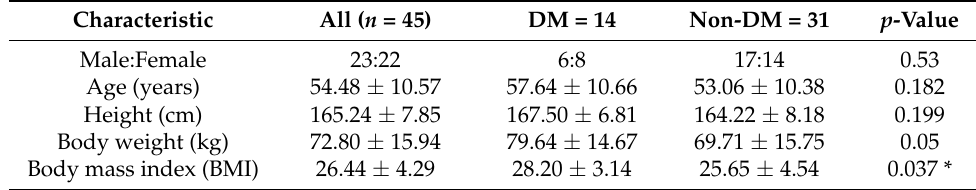
Table 1. Demographic data of participants.